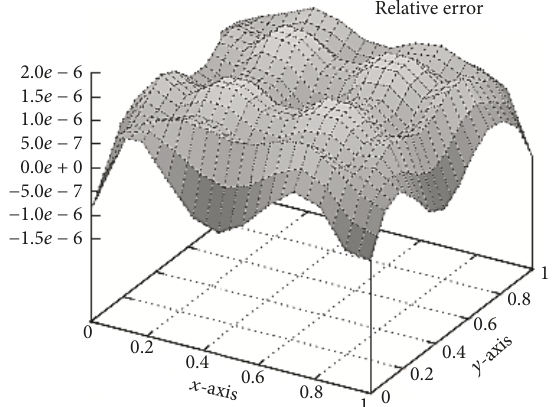
Figure 2: Experiment number 2, error solutions.